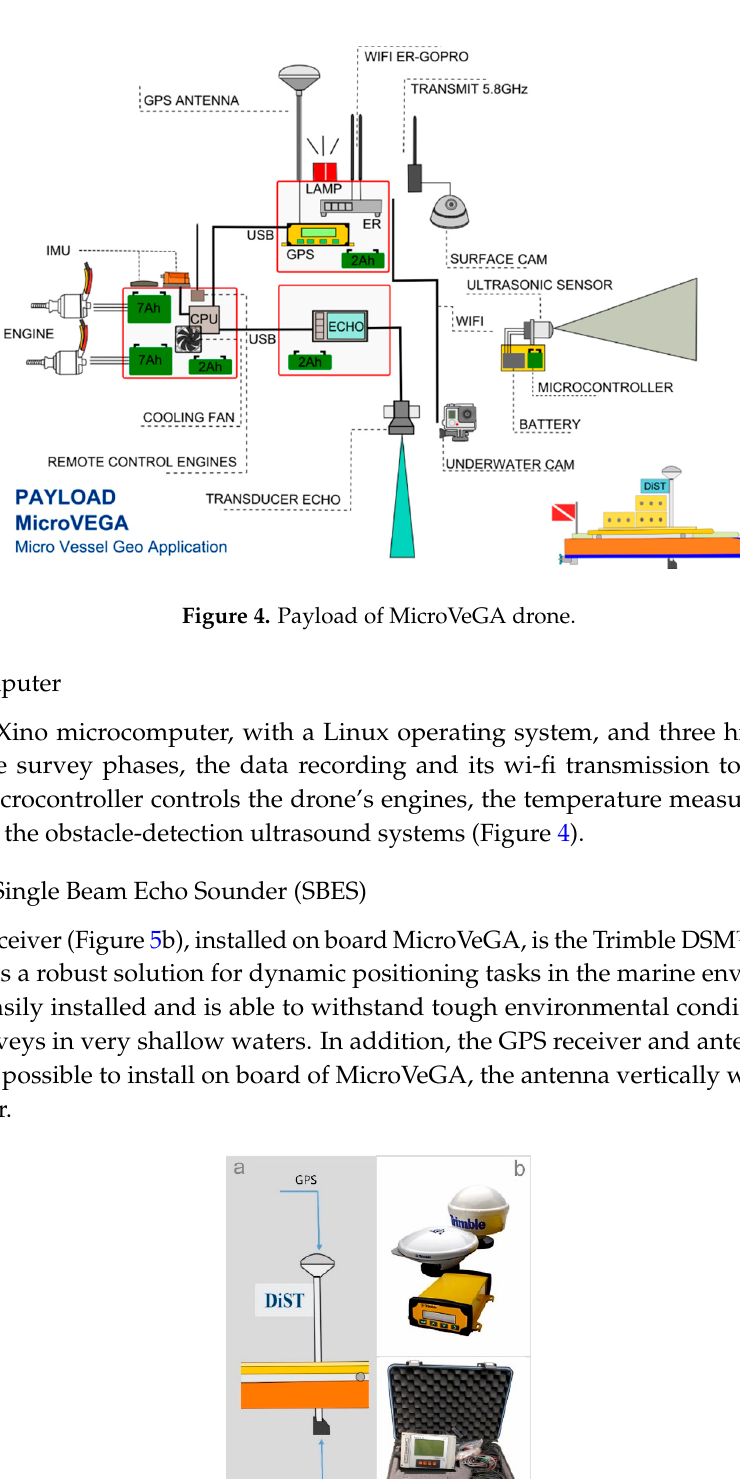
Figure 5. ( a ) Installation positions of the GPS and echo sounder on drone; ( b ) Trimble DSM232 GPS; ( c ) Omex Sonarlite echo sounder.